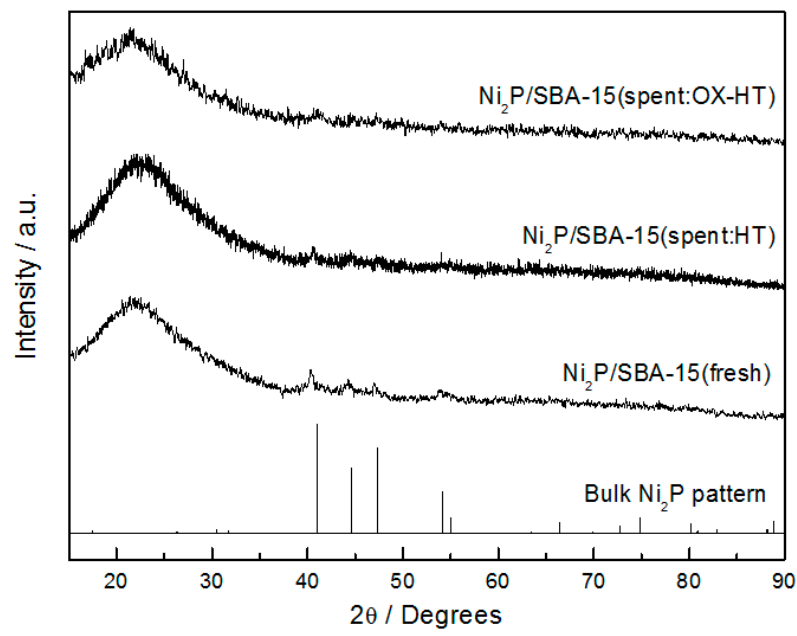
Figure 1. XRD patterns of fresh and spent Ni 2 P/SBA ‐ 15 catalyst samples.